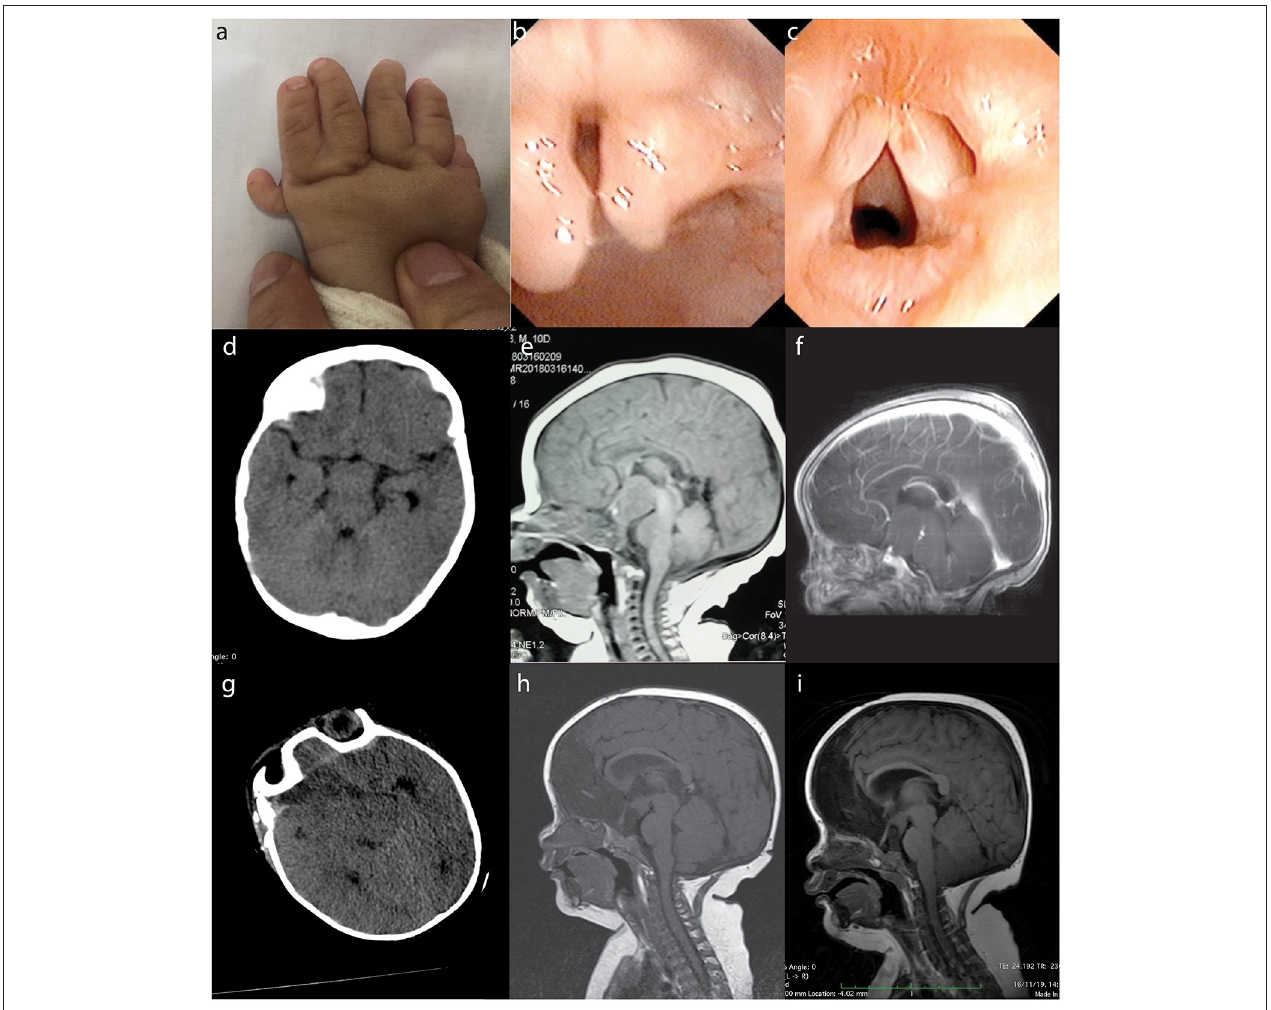
FIGURE 1 | PHS in a 7-month-old boy. The patient presented with typical morphological features of PHS such as polydactyly and syndactyly ( a : left hand), bifid epiglottis (b) , and laryngomalacia (c) . Preoperative CT ( d : at 7 months of age), non-contrast MRI ( e : 12 days postnatal), and contrast-enhanced MRI ( f : 7 months of age) showed a suprasellar lesion. Postoperative CT (g) and MRI (h) revealed subtotal removal of the lesion, and follow-up MRI 1 year later showed no tumor regrowth (i) . PHS, Pallister–Hall syndrome; CT, computed tomography; MRI, magnetic resonance